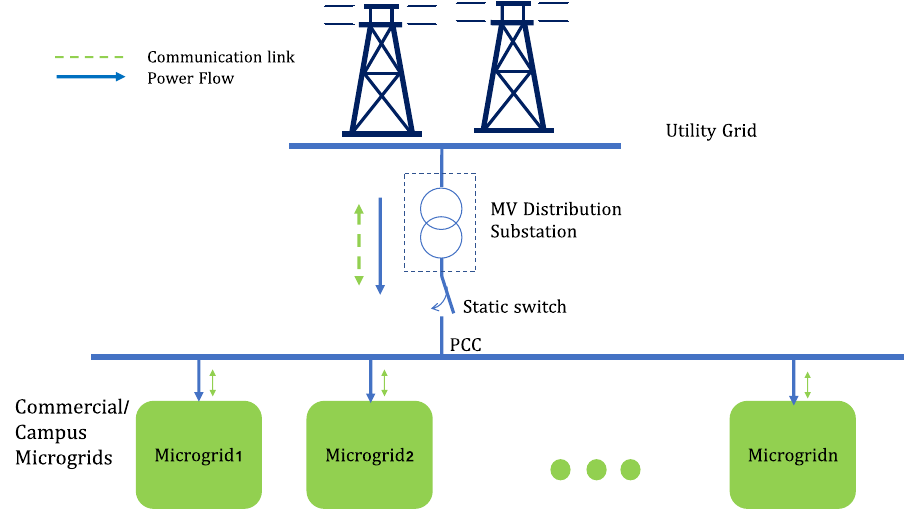
Figure 1. The basic layout for a system with multiple µ Grids that can connect and disconnect from the utility grid.